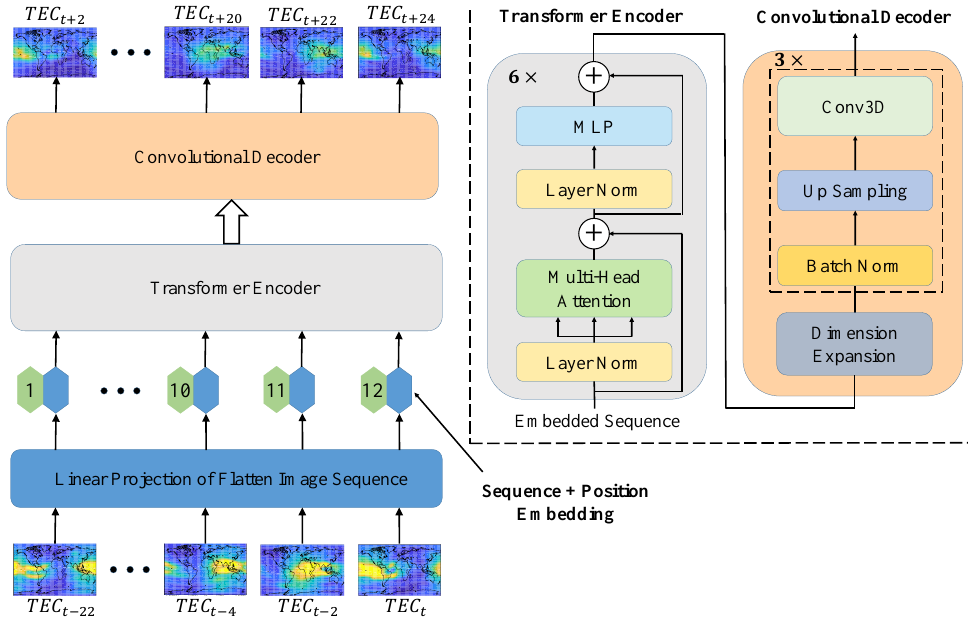
Figure 1. Model overview. We flatten the TEC maps into 1D matrices, linearly embed each of them, add position embeddings and feed the embedding image sequence of vectors to a standard transformer encoder. Then, a decoder consisting of convolutional neural networks and an up sampling layer is responsible for outputting the prediction